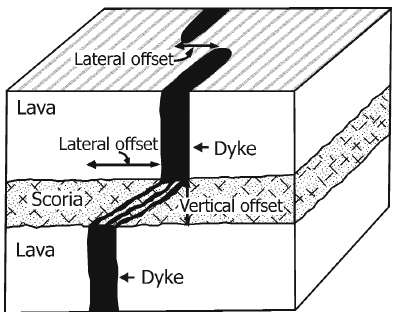
Fig. 10. When dykes dissect contacts between lava flows, particularly scoria layers that are still weak when the dyke injection occurs, they commonly become lat- erally and vertically offset ( cf. fig. 3). Some dyke seg- ments, however, are connected by thin igneous sheets, like here. Lateral dyke offsets are also very common, both in eroded, extinct dyke swarms, like here, as well as at the surfaces of active rift zones and volcanic edi- fices, where the feeder dykes are seen as volcanic fis- sures. For example, the Laki Volcanic Fissure, part of which is seen in fig. 6, is offset in many places ( cf. Thordarson and Self, 1993).